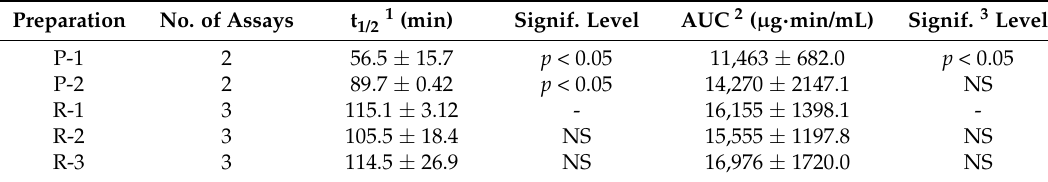
Table 4. Pharmacokinetic parameters for the different hTSH preparations. Preparation